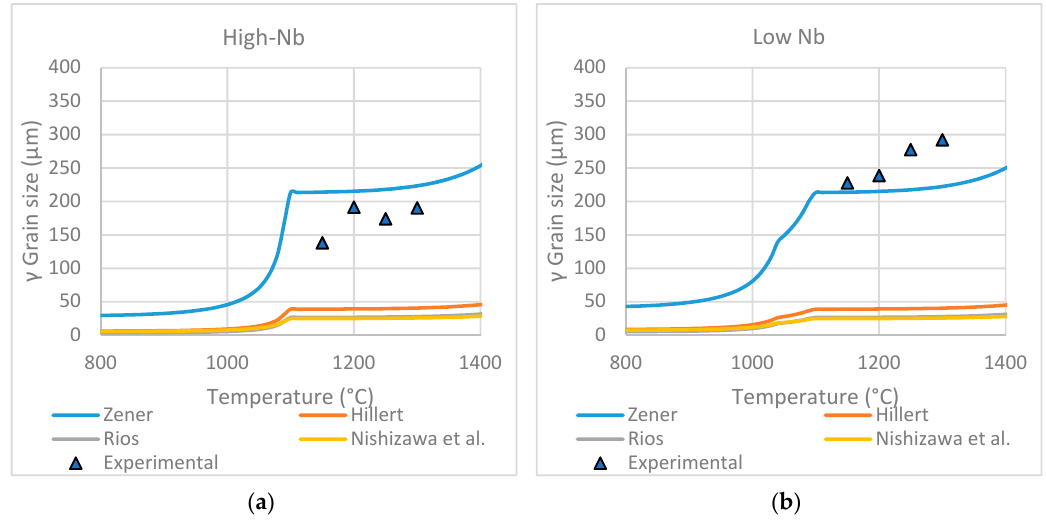
Figure 12. Experimentally determined PAGS compared to calculated predictions: ( a ) High-Nb steel; and ( b ) Low-Nb steel.